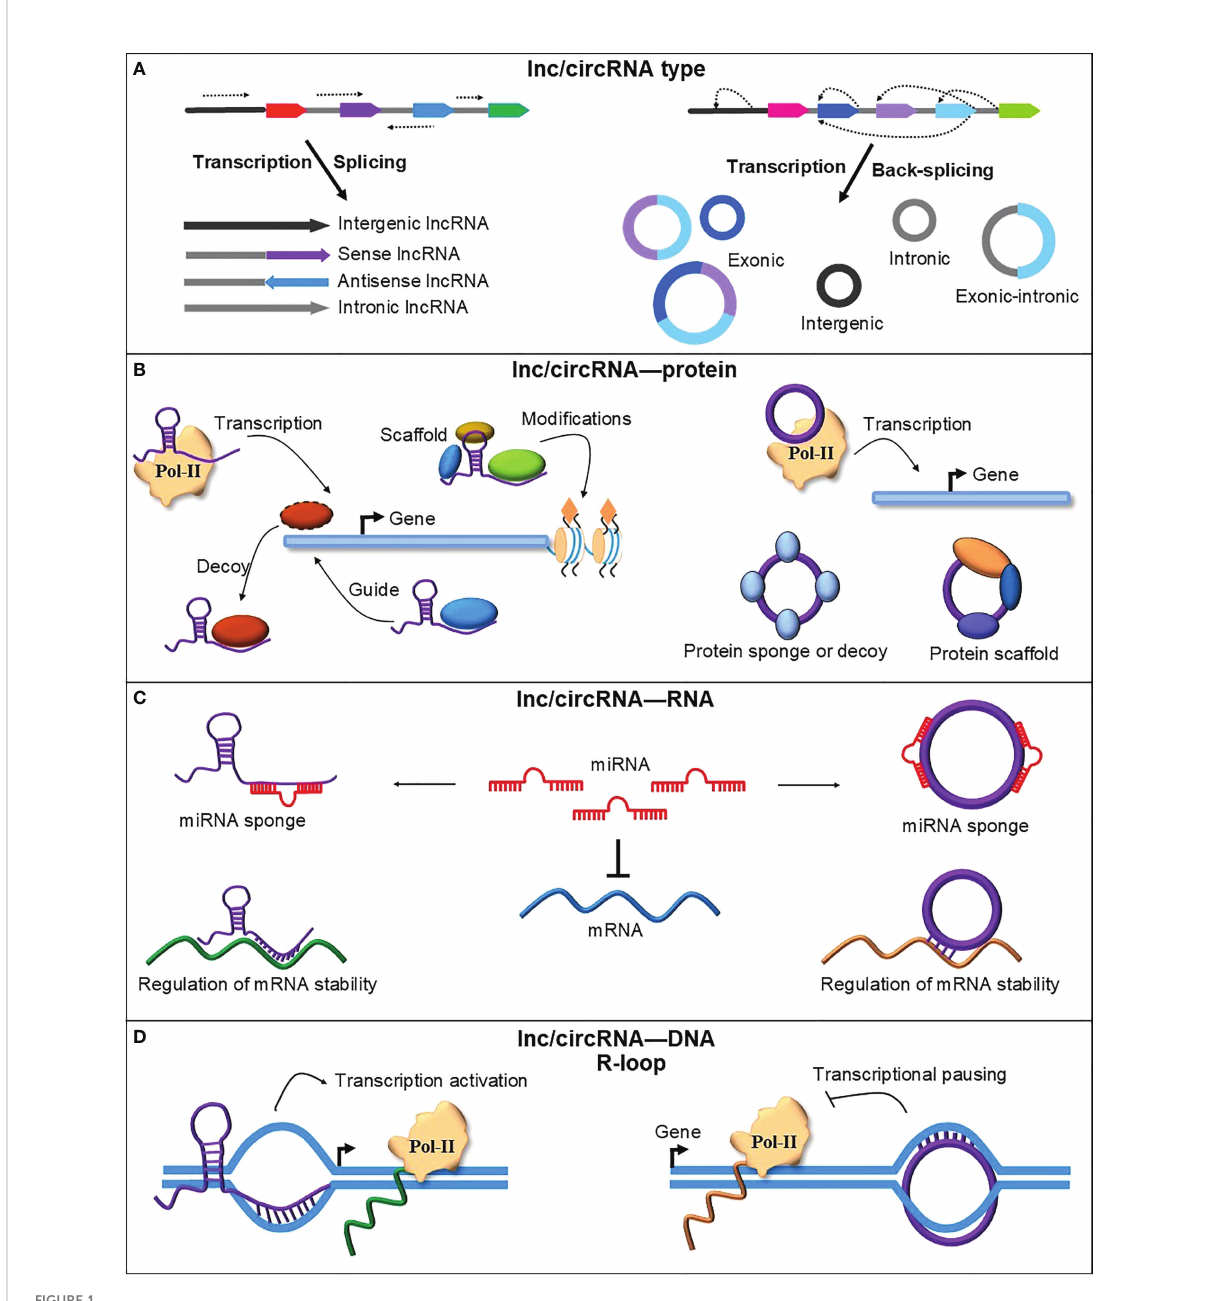
FIGURE 1 A schematic representation of lncRNAs and circRNAs types and their mode of action. (A) RNA polymerase II transcription and canonical splicing produce different types of lncRNAs from genic and intergenic regions. CircRNAs are also transcribed using RNA polymerase II but spliced via an uncanonical type of splicing named backsplicing. CircRNAs are produced from genic and intergenic regions but mainly from the circularization of one or more exons. (B) LncRNAs and circRNAs could interact with different proteins to perform their function. They can interact with RNA Polymerase II (Pol-II) components to regulate transcription. LncRNAs can recruit different proteins, such as transcription factors and chromatin modi fi ers, to guide them to their place of activity or titrate them away from their site of action to signal the activation or deactivation of gene expression. CircRNA can also sponge or scaffold various proteins to perform their cellular function, such as regulating gene expression, translation, and cell division (Huang et al., 2020). (C) LncRNAs and circRNAs can bind to other RNAs and regulate gene expression. LncRNAs and circRNAs block or reduce the negative effect of miRNAs on target mRNAs by sponging miRNAs. LncRNAs and circRNAs can also modulate the stability and translation of mRNAs by directly binding their target mRNAs on the recognition site of miRNAs or RNA-binding proteins (Sebastian- delaCruz et al., 2021; Wu et al., 2022). (D) LncRNAs and circRNAs can directly bind DNA and form an RNA-DNA hybrid or R-loop. By forming the R-loops, lncRNAs and circRNAs regulate the transcription of their parent or adjacent genes by affecting the RNA polymerase II transcriptional